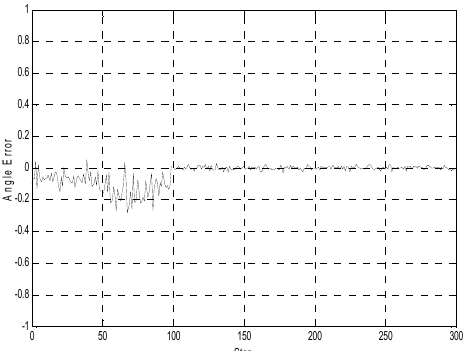
Figure 7. Orientation estimates (the first 100 steps using the EKF method without considering the